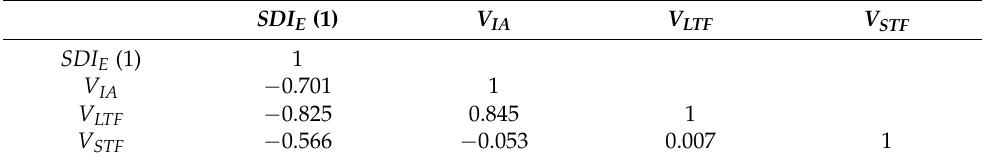
Table 3. Correlations matrix between SDI E and indicators of financial flows at the